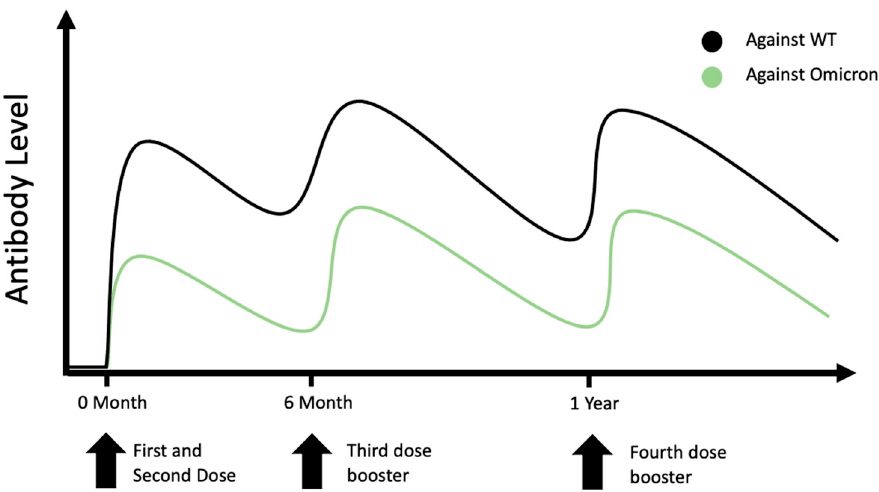
Figure 1. Changes in serum-neutralizing antibodies against SARS-CoV-2 Wild-Type virus and Omicron variant with time. Vaccine efficacy started to decline 2–4 months after the third-dose booster [13]. After third-dose booster, level of neutralizing antibodies against Omicron variant was lower than that against other strains such Wild-Type, Beta and Delta variants [8,15,16]. Furthermore, the response to the fourth-dose booster was comparable to the third-dose booster [22,23].